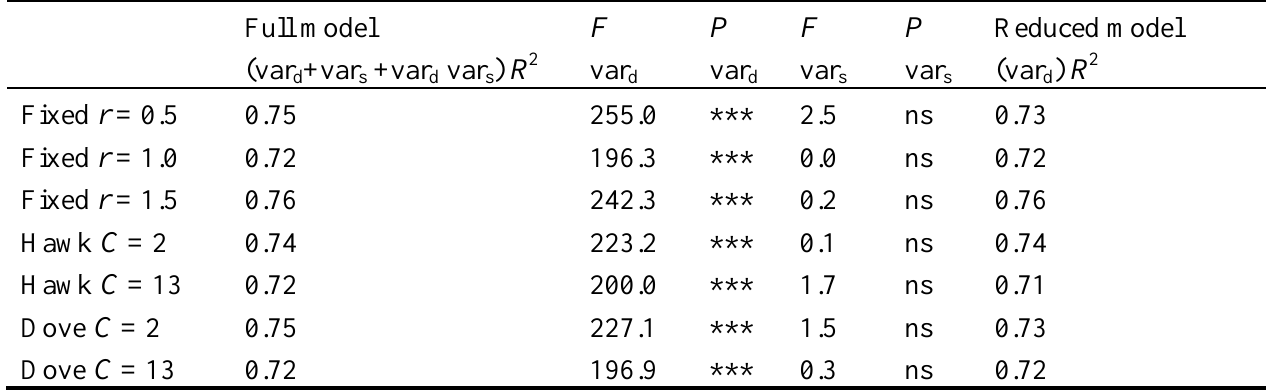
Table 1. Degree and strength variance as predictors for absorption times. Results of general linear models (GLMs) with identity link function fitted to absorption times. Fixed: fixed fitness case, Hawk: a single Hawk invader, Dove: a single Dove invader. F -values and significance levels are given for a two-way ANOVA for the full